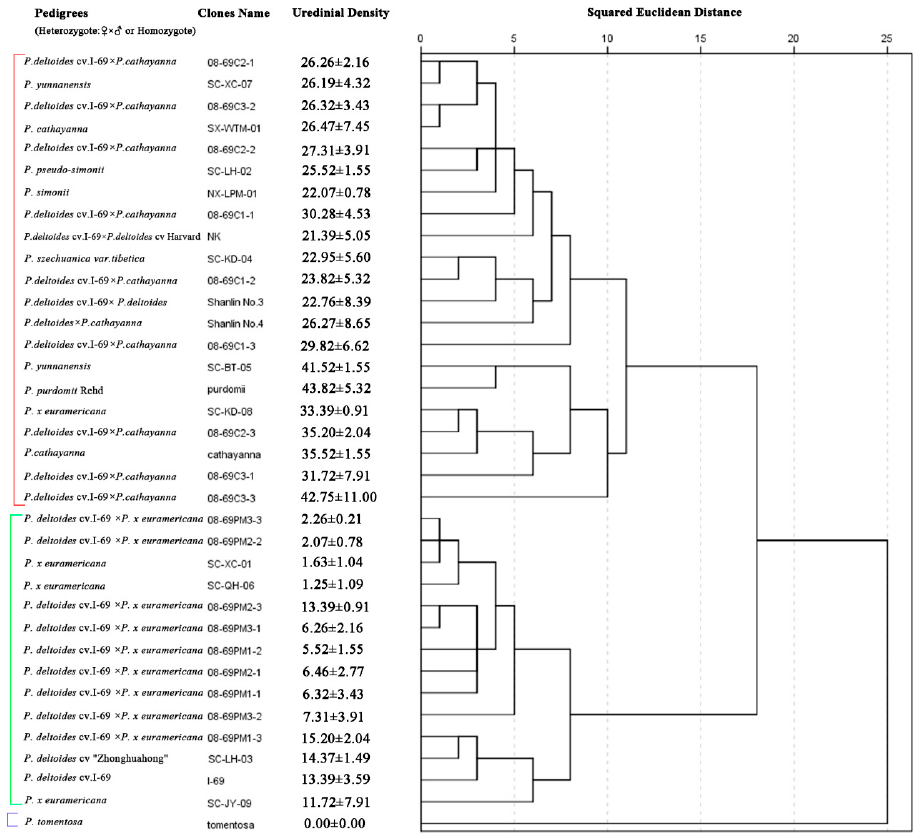
Figure 1. Dendrogram of 36 poplar clones clustered according to uredinial densities recorded in Weihe River poplar experimental station, China, in September 2018. Melampsora larici-populina was the sole rust.